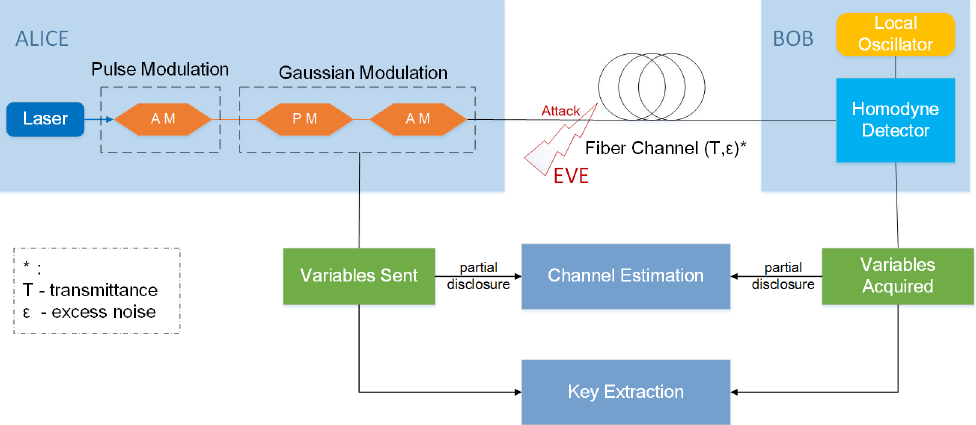
Figure 1. In the GMCS CVQKD protocol, Alice encodes the secret key information by modulating the quadratures x and p of coherent states with independent Gaussian distributions and sends them to Bob through an insecure channel controlled by Eve. Next, the homodyne detector on Bob’s end obtains the transmitted information. Then, some of the shared Gaussian variables are disclosed for channel estimation. Lastly, shared Gaussian variables are used to extract